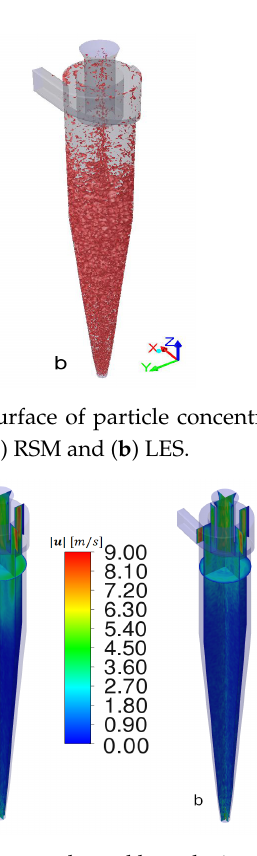
Figure 10. Contours coloured by velocity magnitude, on the planes x = 0, y = 0, and z = 0 from the VOF-DEM models at flow-time 4 s: ( a ) RSM and ( b ) LES.